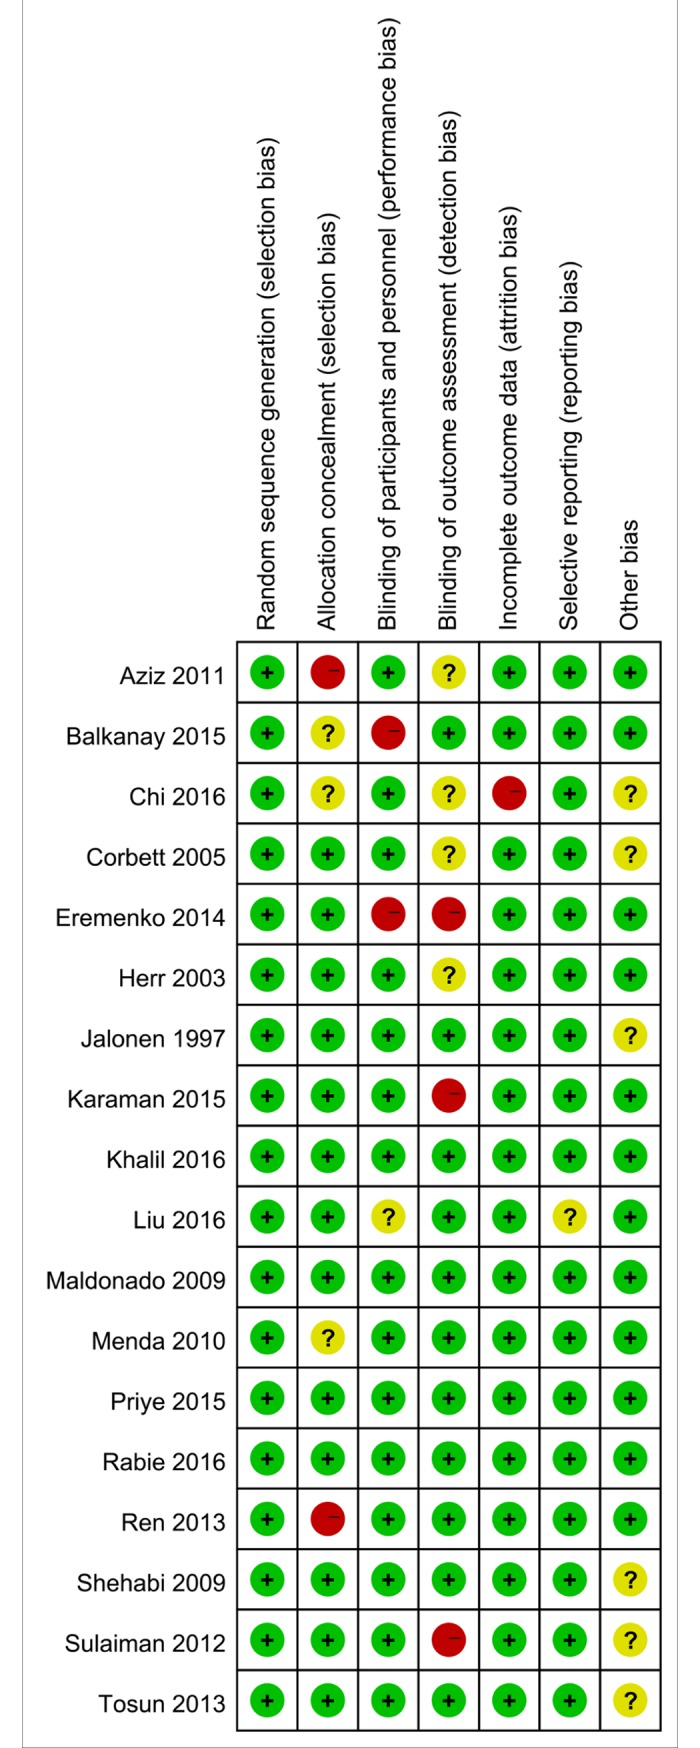
Risk of bias summary: Review authors' judgements about each risk of bias item for each included study.